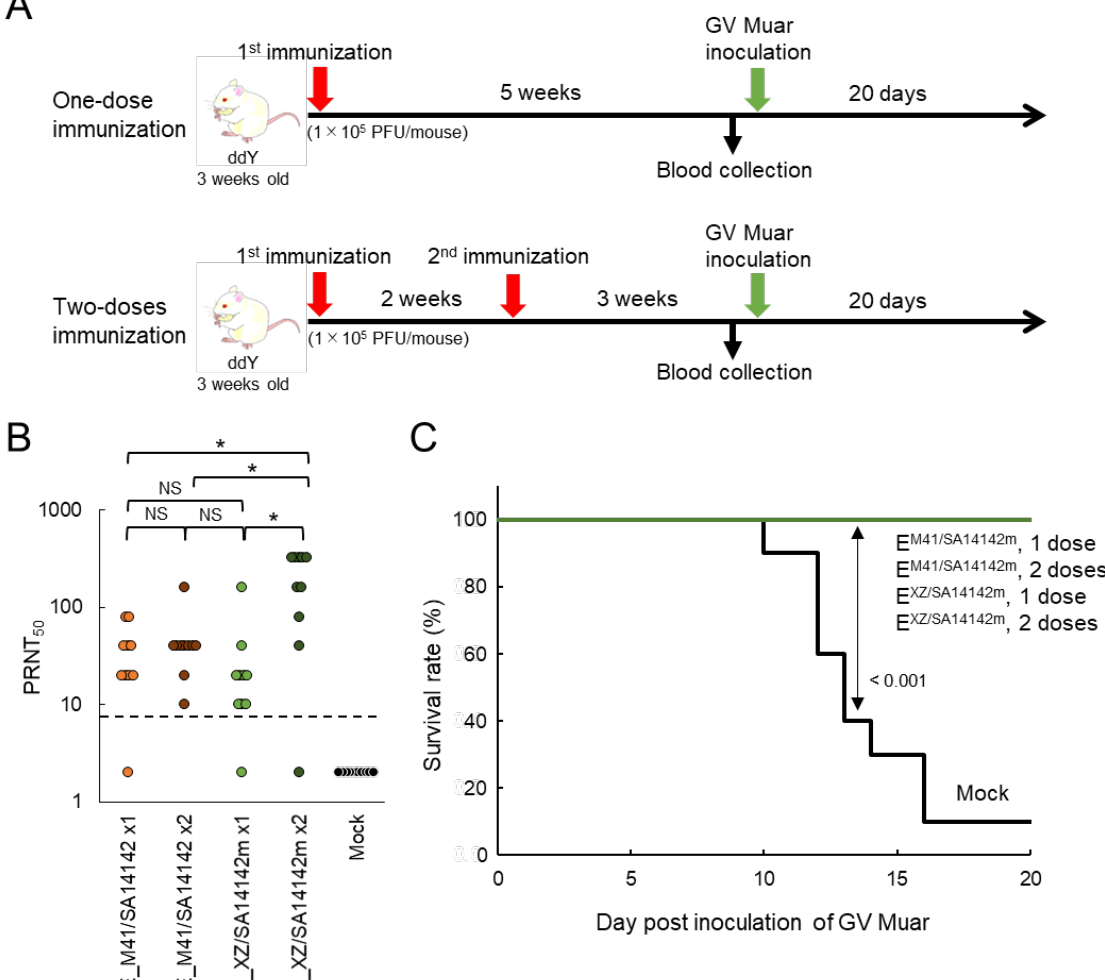
Figure 6. Protective capacity of high-titer recombinant JEV strains against GV Muar strain in mice. ( A ) Experimental timeline. For single-dose immunization groups, mice were inoculated i.p. with 1 × 10 5 PFU of E M41/SA14142m ( n = 10) or E XZ/SA14142m ( n = 10), or mock-inoculated ( n = 10). Double-dose immunization group mice were inoculated i.p. with 1 × 10 5 PFU of E M41/SA14142m ( n = 10) or E XZ/SA14142m ( n = 10) and were immunized again two weeks after the first immunization. At five weeks after the initial immunization, mice were bled to determine serum PRNT 50 and then inoculated i.p. with 1 × 10 4 PFU of Muar strain and observed for 20 days. ( B ) Neutralization activity of serum taken from immunized mice against GV Muar. Dotted line: detection limit. Significance was analyzed using the Kruskal-Wallis test (* 0.01 < p < 0.05); NS: not statistically significant. ( C ) Survival curve of immunized mice after challenge with GV Muar strain. Significant p values by log-rank test are also indicated. Table 2. Neutralization titers (PRNT 50 ) and results of indirect immunofluorescent analysis (IFA) of sera from mice inoculated with one or two doses of recombinant JEVs 1 .